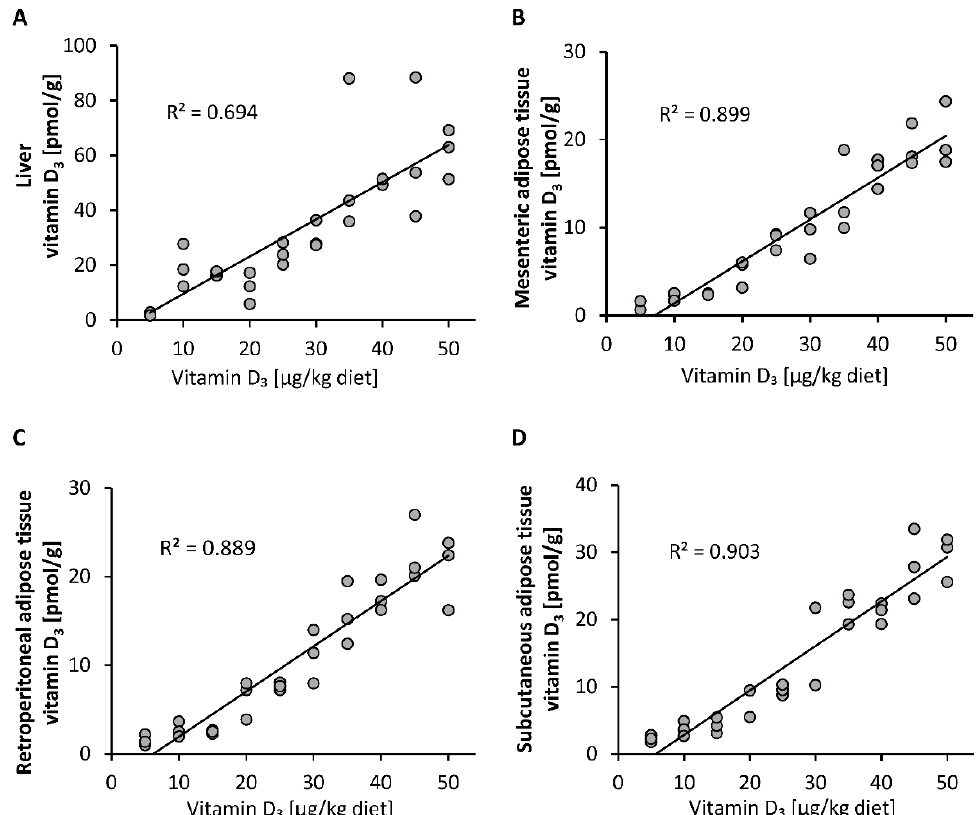
Figure 2. Concentrations of vitamin D 3 in the liver ( A ) and mesenteric ( B ), retroperitoneal ( C ) and subcutaneous ( D ) adipose tissues of mice that were fed 10 different doses of dietary vitamin D 3 for three weeks ( n = 3). The regression line is linear for vitamin D 3 in the analyzed tissues. R 2 , squared correlation.